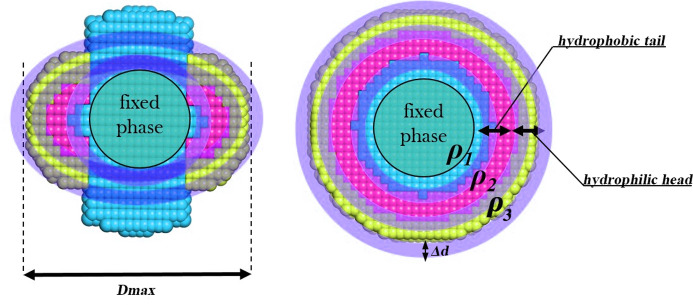
A DAMEMB-generated initial search volume for multiphase modelling of membrane proteins with MONSA. The protein phase, ρ1 (cyan), is defined within a spherical core region, located at the origin of the search volume. The core volume is surrounded by two distinct phases, ρ2 and ρ3, corresponding to the tail (pink) and head group (yellow) regions of a detergent molecule. The thickness of each phase, as well as that of the boundary region Δd, may be specified by the user.